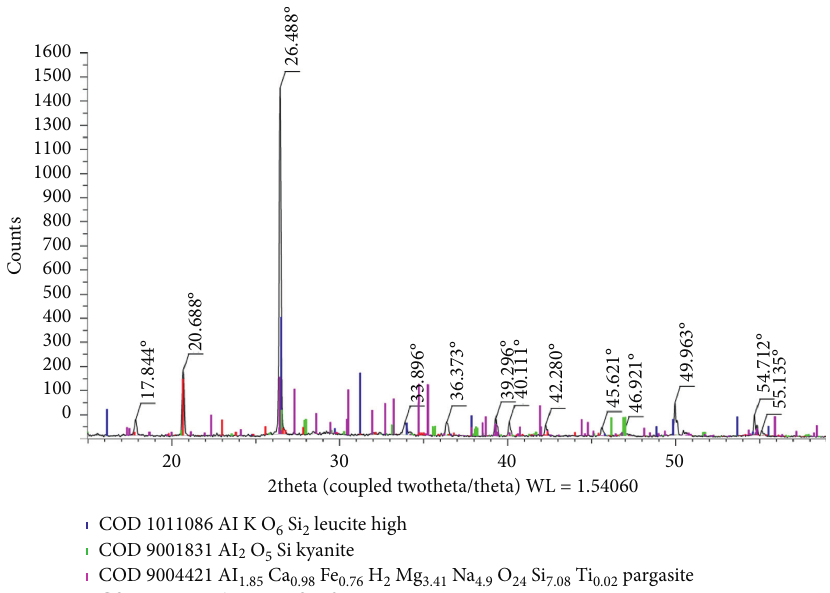
Figure 8: XRD diffractogram for OPC (H